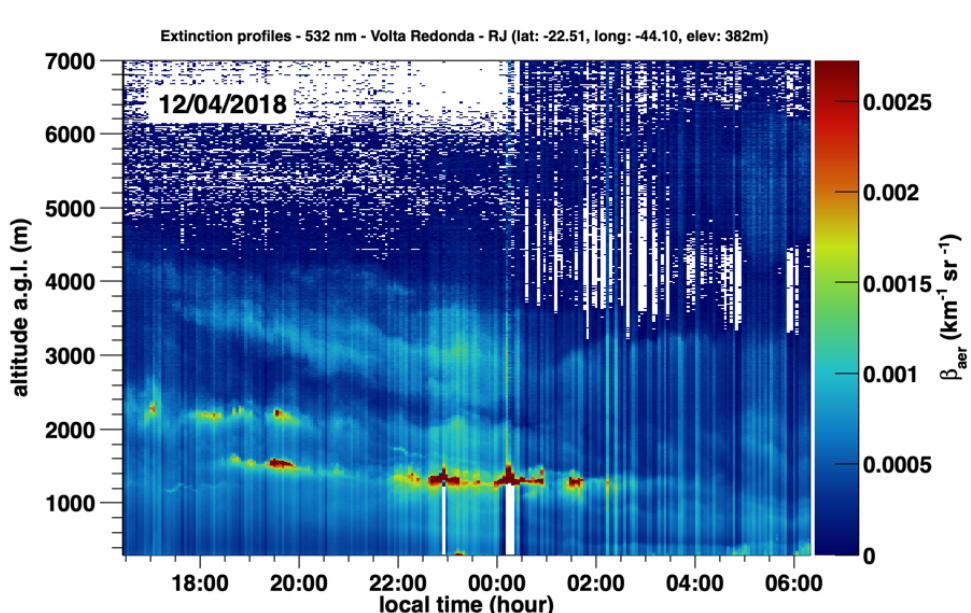
Figure 9. Aerosol backscatter profiles image in Volta Redonda city on 4 December 2018 retrieved by KFS inversion method applying the lidar ratio value of 55 ± 22 sr.